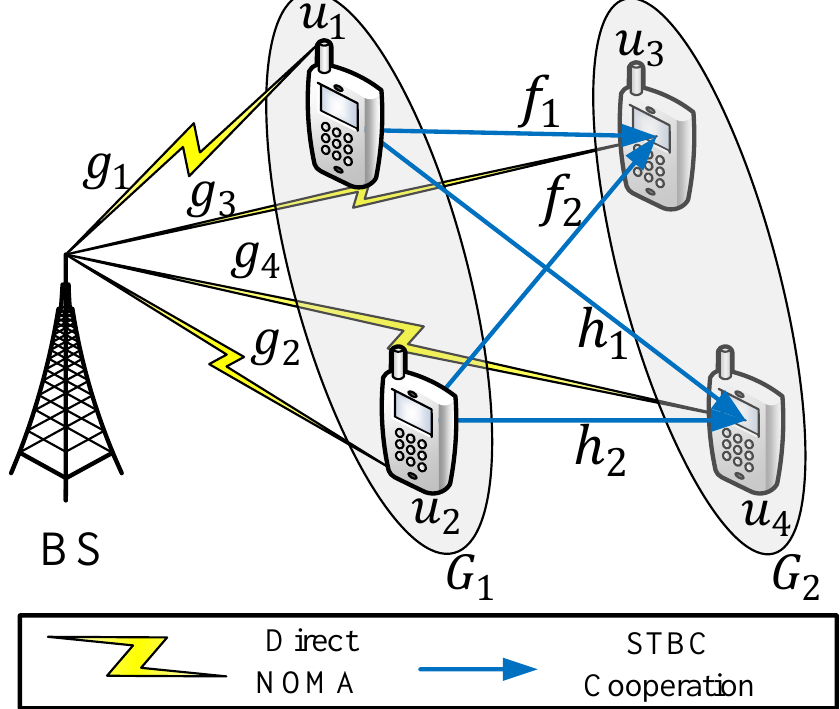
Figure 1. System model for cooperative communication with Alamouti-coded downlink NOMA for U =